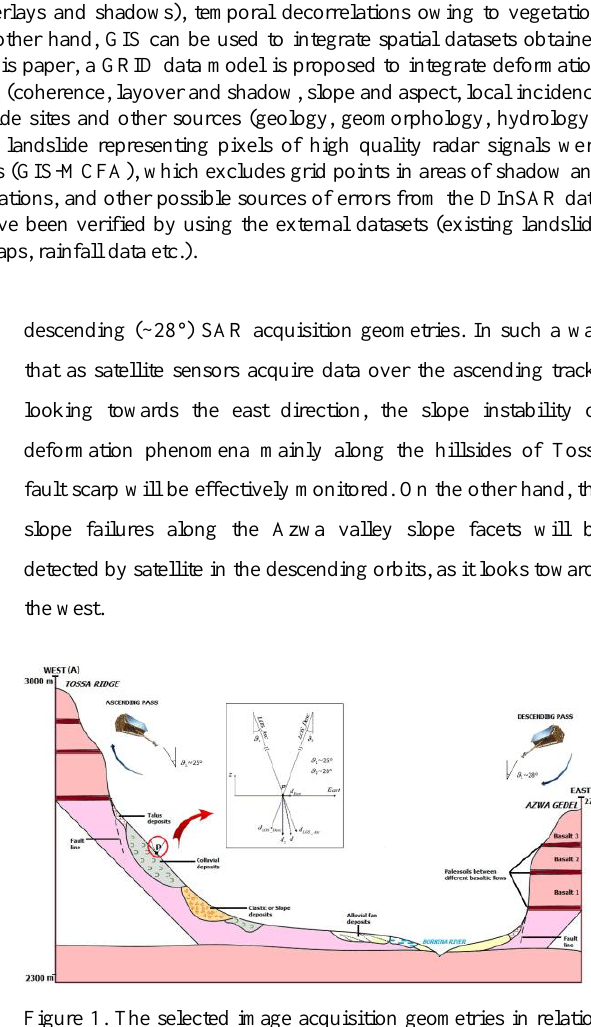
Figure 1. The selected image acquisition geometries in relation to the local topography and target landslide